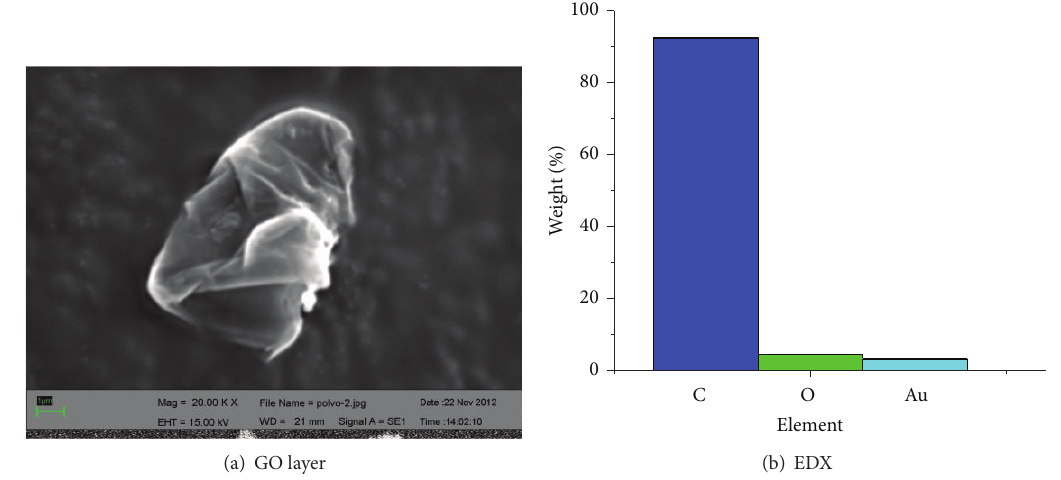
Figure 5: SEM image of GO and the characterized area through EDX.